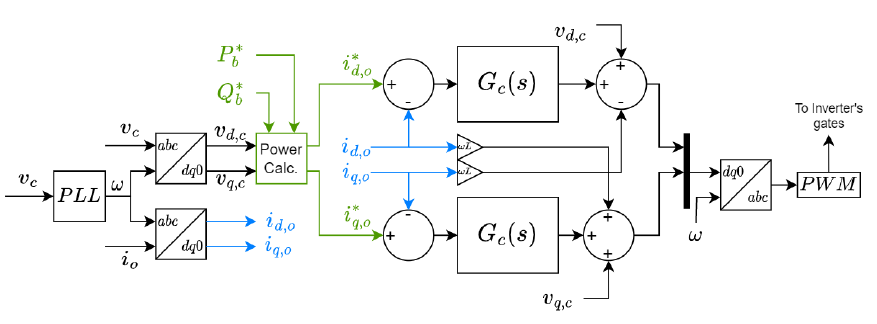
Figure 5. Block diagram of the primary control